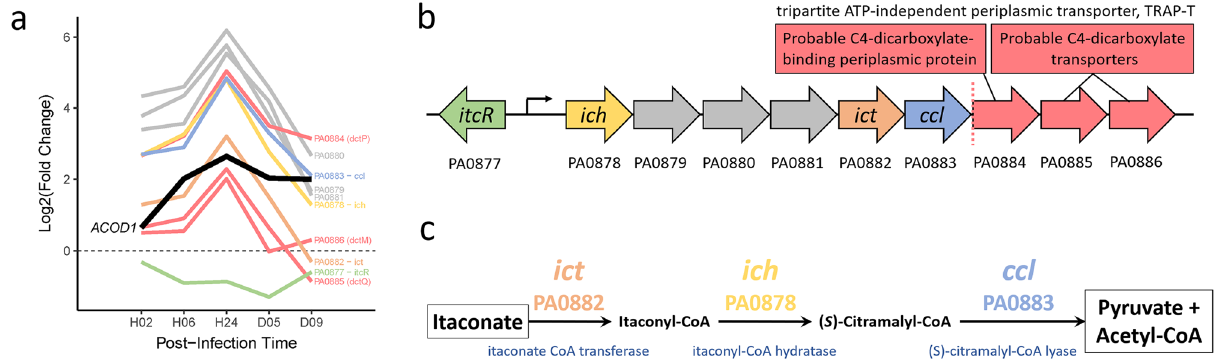
Figure 7. Up-regulation of itaconate catabolism genes during acute infection. ( a ) Expression of PA0877 to PA0886 (log2FC vs. culture). The horizontal dotted-black line indicates the expression of PAO1 genes in culture. The thick solid black line shows the expression of the rabbit host ACOD1 (aka IRG1 ) gene 21 (BioProject Accesion ID: PRJNA324375) that encodes aconitate decarboxylase 1 that catalyzes cis-aconitate to itaconate. ( b ) Schematic of the predicted operon (PA0878–PA0883) containing the three itaconate catabolism genes ( ich , ict , and ccl ) and three other genes (grey). The downstream, predicted three-gene operon shown by red arrows encodes a probable TRAP-T that may transport itaconate into PAO1. The vertical dotted red line separates the two predicted operons. ( c ) Catabolism of itaconate to pyruvate and acetyl-CoA. Panels ( b ) and ( c ) were adapted from Hanko et al. 57